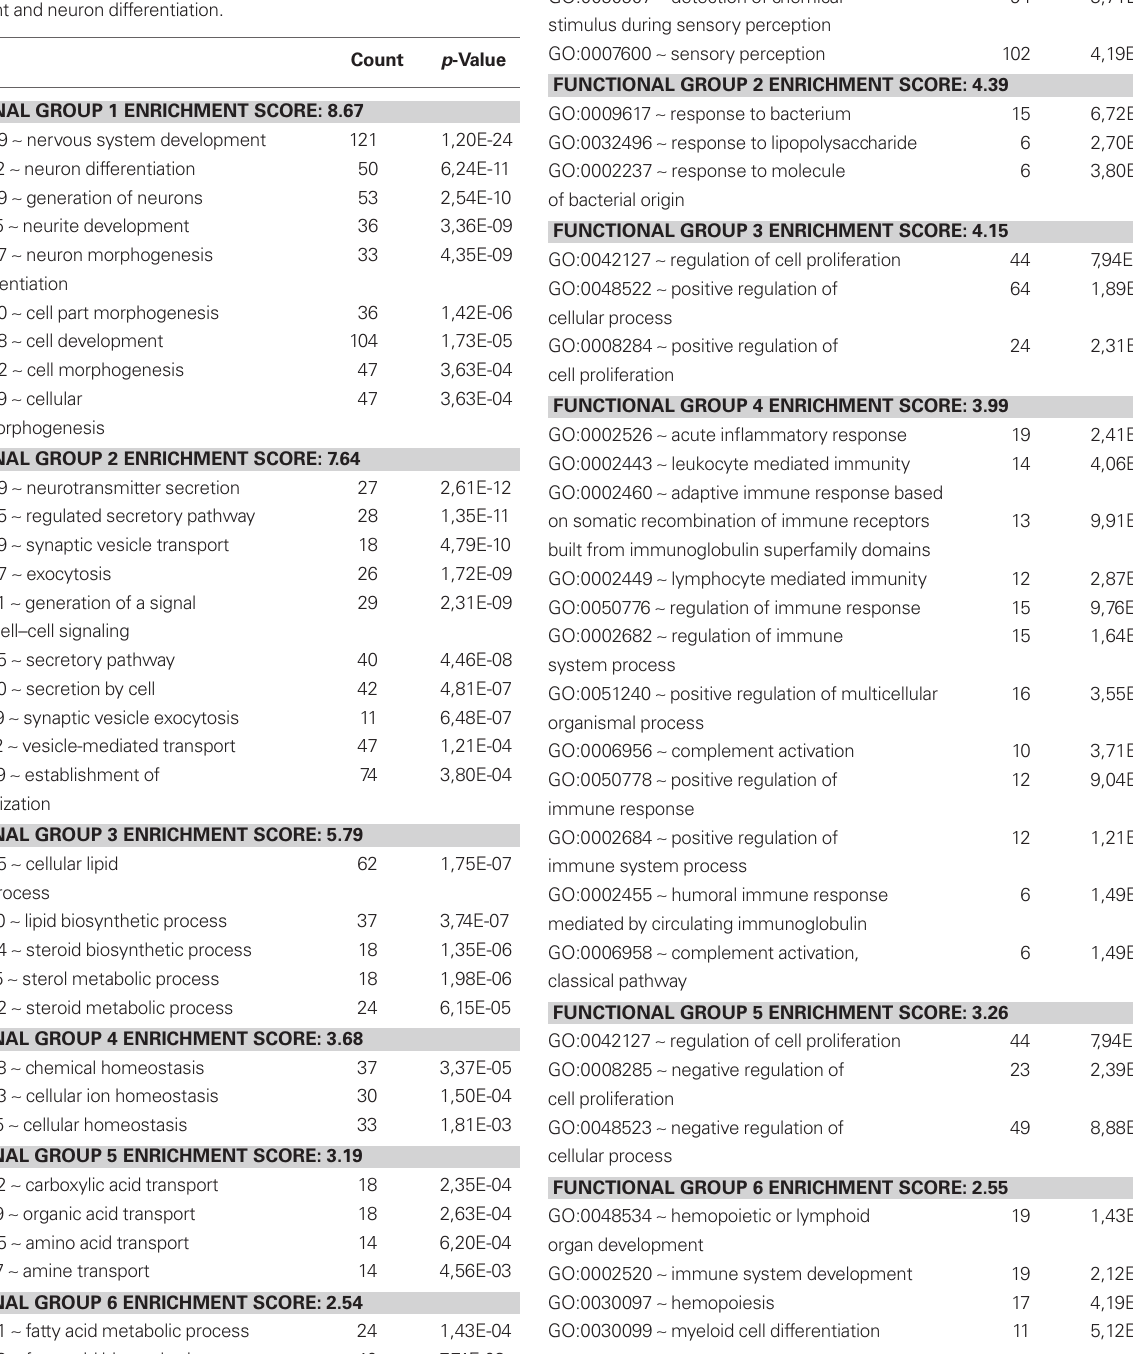
Table 1 | replantation vs control. Cluster analysis of regulated genes, employing the Database for Annotation, Visualization, and Integrated Discovery (DAVID). It was possible to group responding genes into functional-related gene groups (GO – Gene Ontology search terms) and cluster analysis of enriched biological themes. The Enrichment score is based on the mean value of the − log of the p -values (EASEscore) for the members in that cluster. A cut-off value of 2.0 was used, which corresponds to a p -value < 0.01. The most enriched cluster contains themes for neurite development and neuron differentiation.